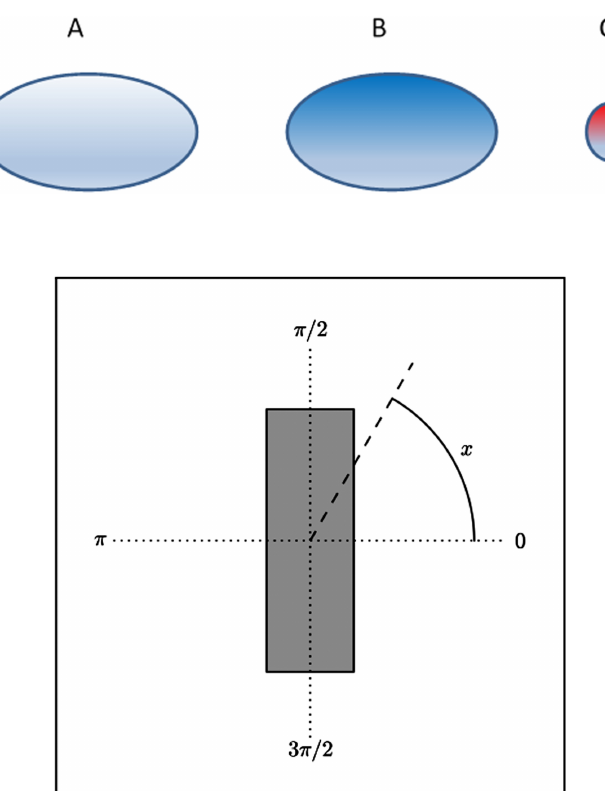
Figure 8. Cylindrical target observed at look angle